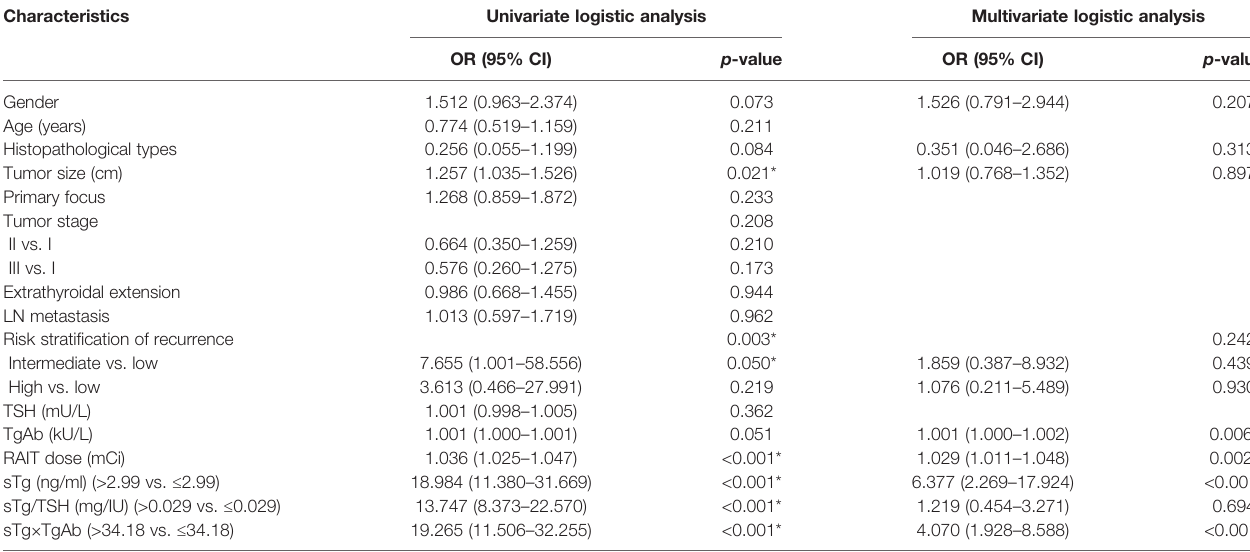
TABLE 4 | Univariate and multivariate logistic regression analyses of tumor characteristics and therapeutic effect. Characteristics